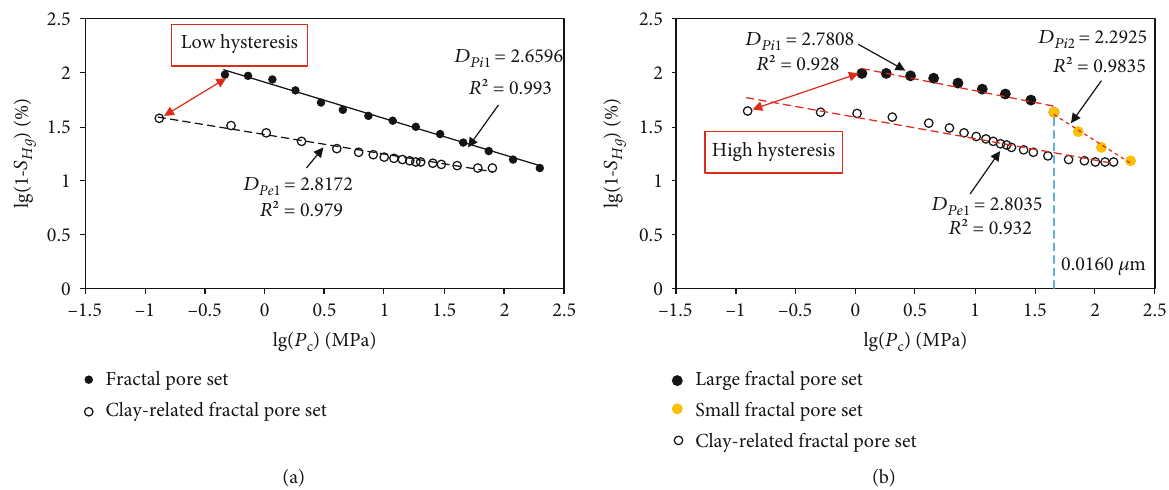
Figure 8: Double logarithmic plots of wetting phase saturation versus capillary pressure from PCMI experiments: (a) type P1 sample from H179; (b) type P2 sample from S22.